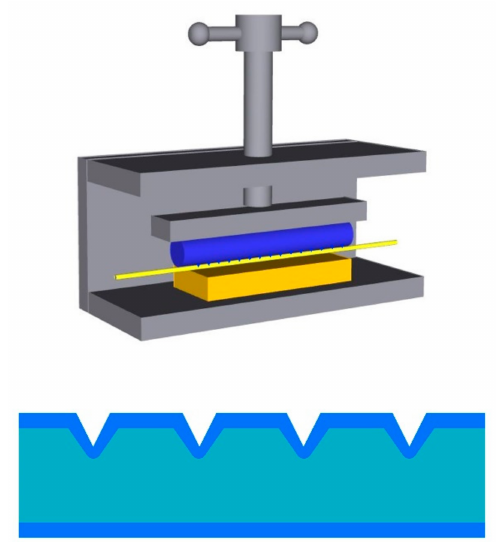
Figure 12. The schematic diagrams of the fabrication process of multi-notched structure on POF, and the structure of multi-notched POF